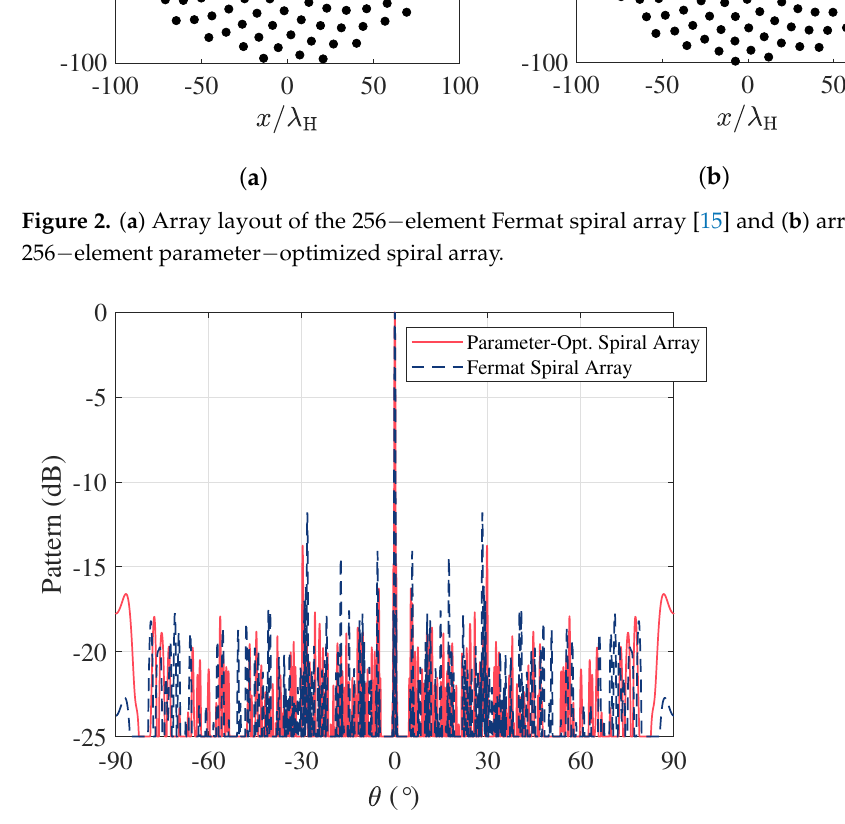
Figure 3. Array factor cuts where the peak sidelobes are located. The dashed line indicates the ϕ = 126.5 ◦ array factor cut of the Fermat spiral array in Figure 2a, and the solid line indicates the ϕ = 152 ◦ array factor cut of the parameter − optimized spiral array in Figure